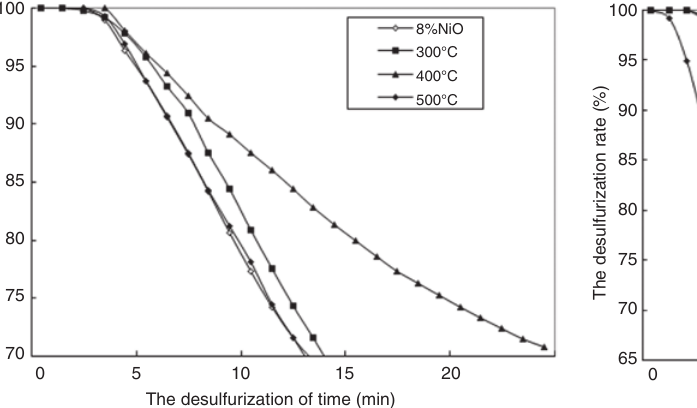
Figure 4: Effect of calcination temperature of different time on the catalyst desulfurization